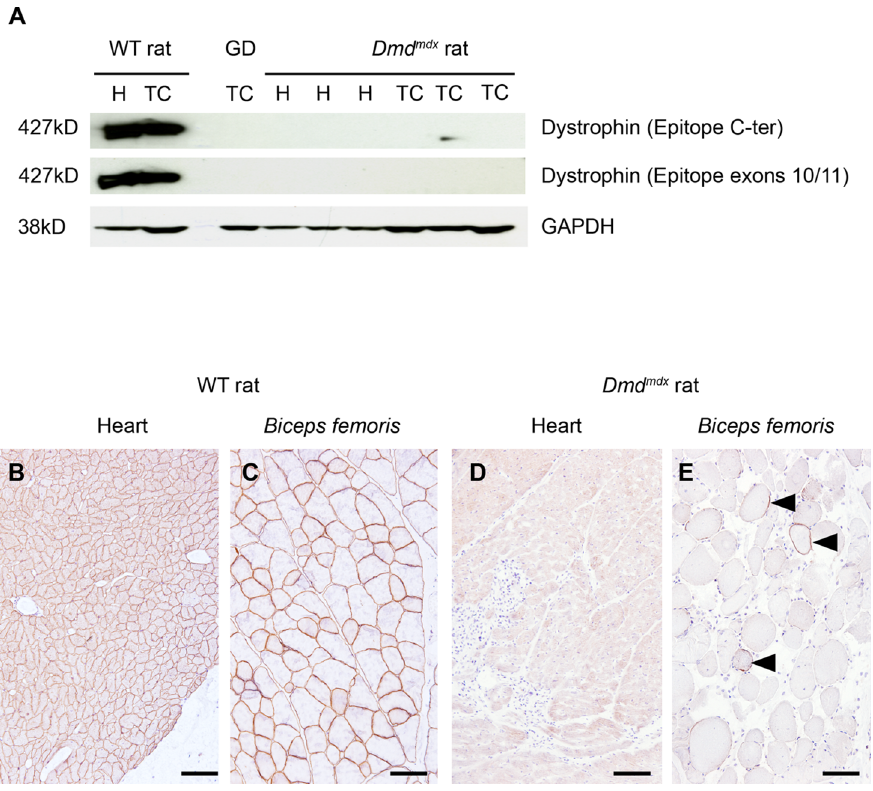
Figure 2. No dystrophin expression was detected in cardiac and skeletal muscles of Dmd mdx rats. ( A ) Male 7 month-old rats of line 61, wild-type littermate controls (WT) and Dmd mdx were sacrificed and biopsies from tibialis cranialis muscles (TC) and hearts (H) were harvested. Western-blot of total proteins (50 m g) was incubated with NCL-DYS2 and Manex1011C monoclonal antibodies (C-terminal and exons 10/11 epitopes, respectively). This revealed undetectable levels of the 427 kDa dystrophin band in line 61 Dmd mdx rats. Muscle from a GRMD dog (GD) was used as negative control and samples from WT rats were used as positive controls. Staining with an anti-GAPDH polyclonal antibody validated equal protein loadings. ( B–E ) Heart and biceps femoris muscles from the same wild-type ( B and C ) and Dmd mdx rats ( D and E ) were assessed for dystrophin expression using immunohistochemistry with Mandys110 monoclonal antibody (against exons 38–39 epitope). Compared to the subsarcolemmal expression of dystrophin in wild-type muscles, no dystrophin was detected in Dmd mdx rats except for the presence in skeletal muscle of only rare scattered revertant positive fibers (arrowheads). Immunolabelling of dystrophin ( B–E ) Bar=100 m m.